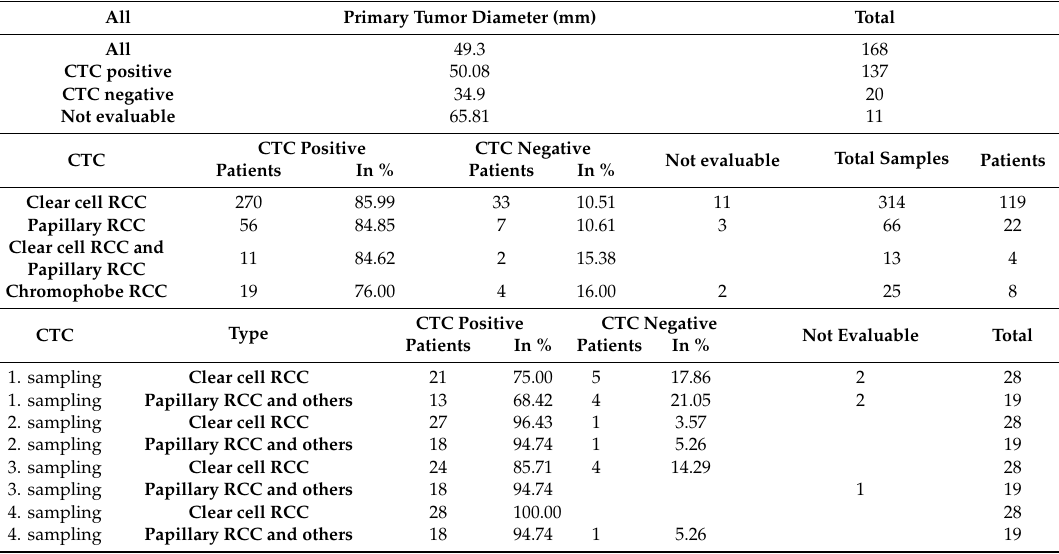
Table 1. Patient